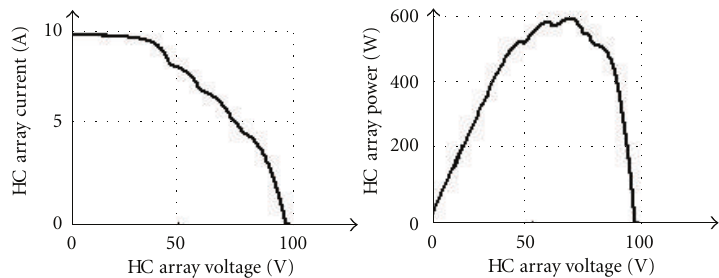
Figure 6: Simulated V-I and V-P characteristics of SPVA configurations for a shading pattern shown in Figure 3.